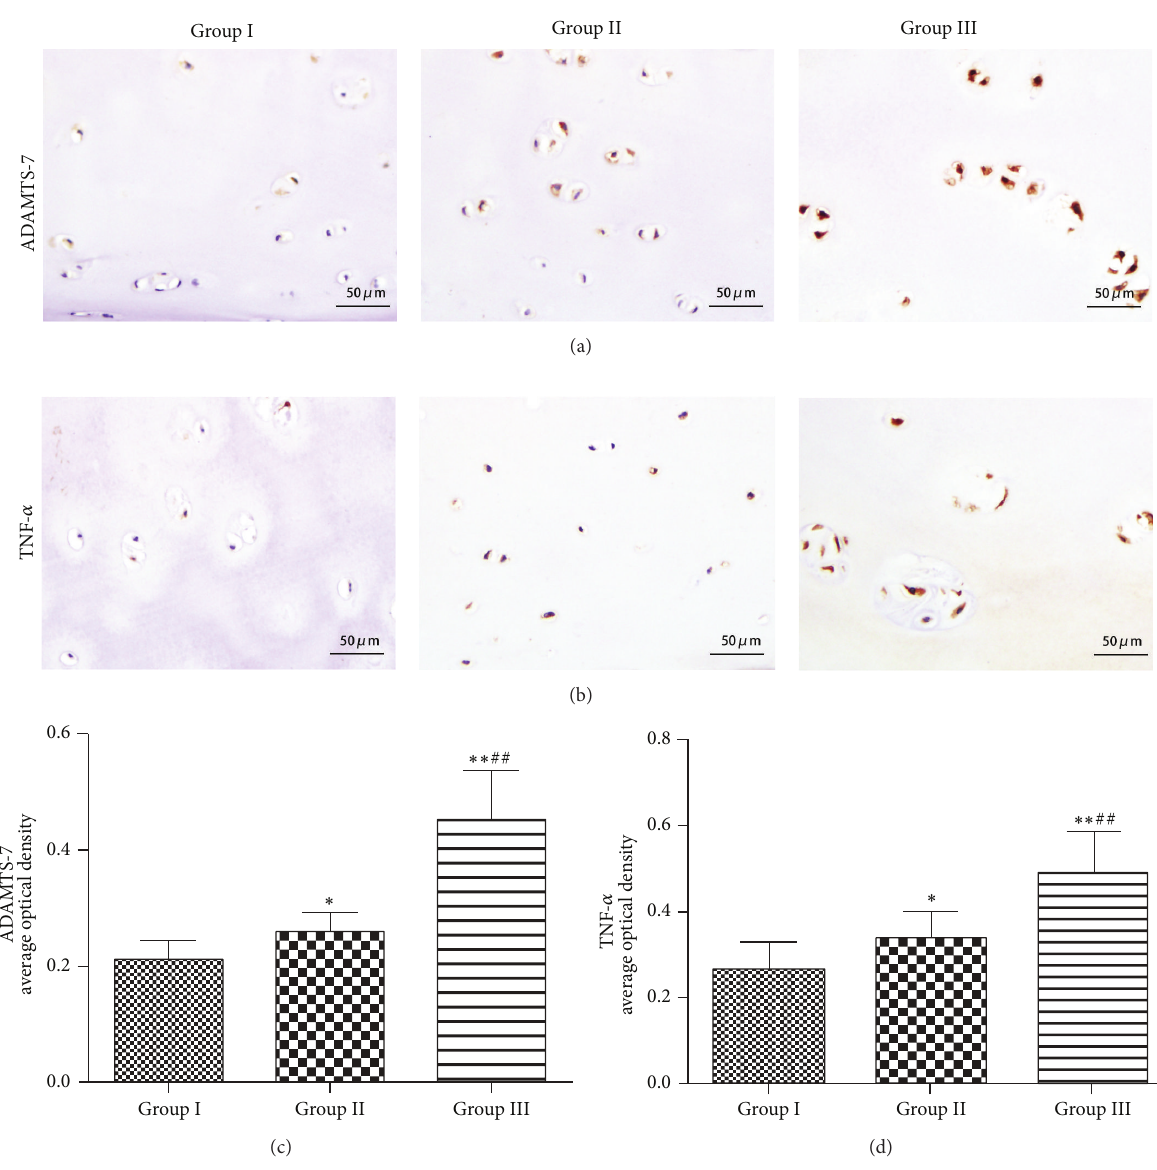
Figure 2: ADAMTS-7 and TNF- 𝛼 are upregulated in ONFH patients. (a) Expression of ADAMTS-7 of cartilage samples of FNF patients and ONFH patients at different stages, assayed by immunohistochemistry. (b) Expression of TNF- 𝛼 in different groups, examined by immunohistochemistrywithanti-TNF- 𝛼 serum.(c)QuantitativeanalysisofADAMTS-7-positiveareaofeachgroup.(d)Quantitativeanalysis of TNF- 𝛼 area of each group. Statistically significant increases in the expression of ADAMTS-7 and TNF- 𝛼 were observed in group II and group III compared with group I ( ∗ 𝑃 < 0.05 , ∗∗ 𝑃 < 0.01 ). Significant increases in the ADAMTS-7 and TNF- 𝛼 expression were observed in group III compared with group II ( # 𝑃 < 0.05 , ## 𝑃 < 0.01